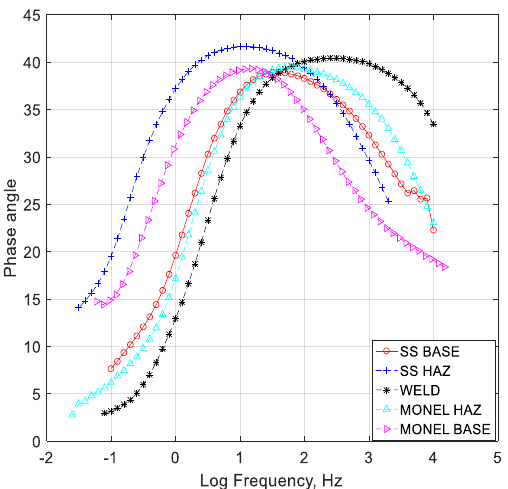
Figure 16. Phase angle variation for CT specimen.